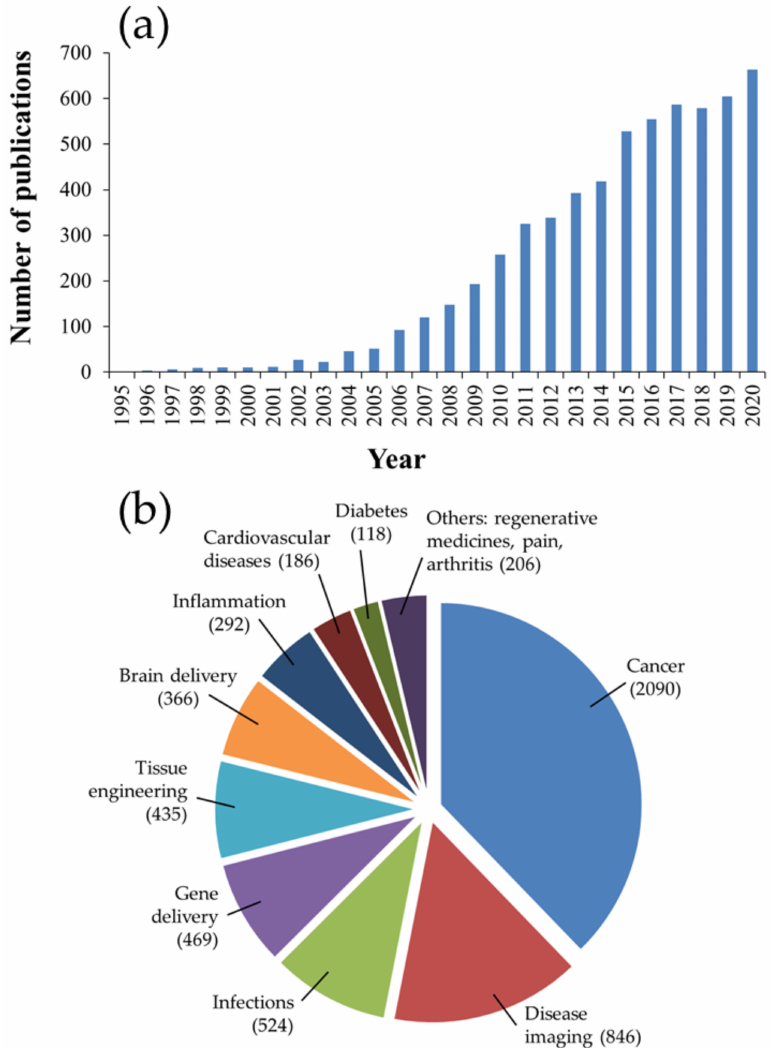
Figure 1. PLGA-related publications on PubMed (accessed on 15 October 2021) between 1995 and 2020. ( a ) Total publications (search keywords used were “PLGA” and “nanoparticles”). ( b ) Publica- tions on PLGA NPs according to biomedical